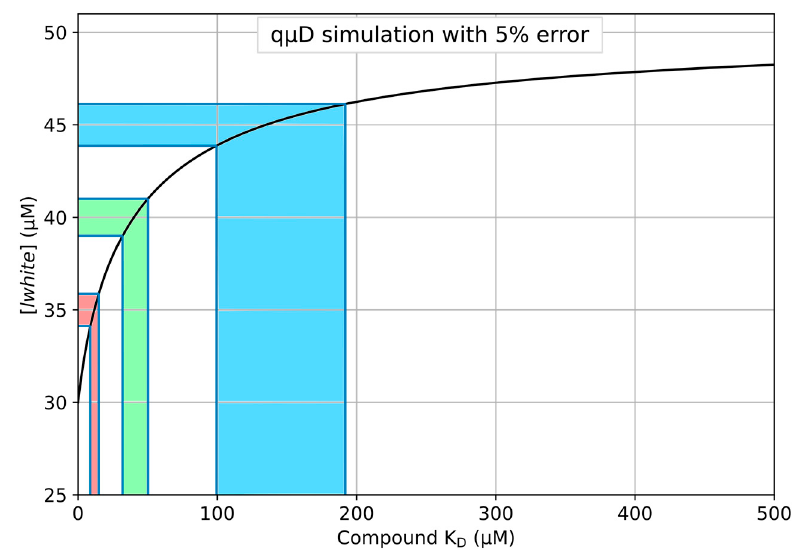
Figure 3. K D determination using a 5% concentration error. Standard microdialysis system, 100 µ L red chamber, 300 µ L white chamber, [t0] = 80 µ M and [l0] = 50 µ M. lwhite compound concentrations of 35 (red), 40 (green) and 45 µ M (blue) give rise to K D ranges of 8.9–14.9 µ M, 31.9–50.1 µ M and 99.4–191.9 µ M respectively.